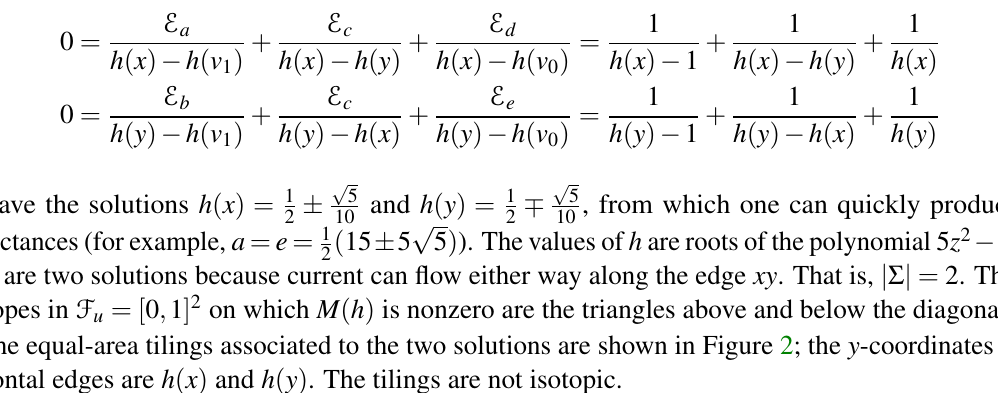
Figure 2: A graph with field is Q ( √ 5 )